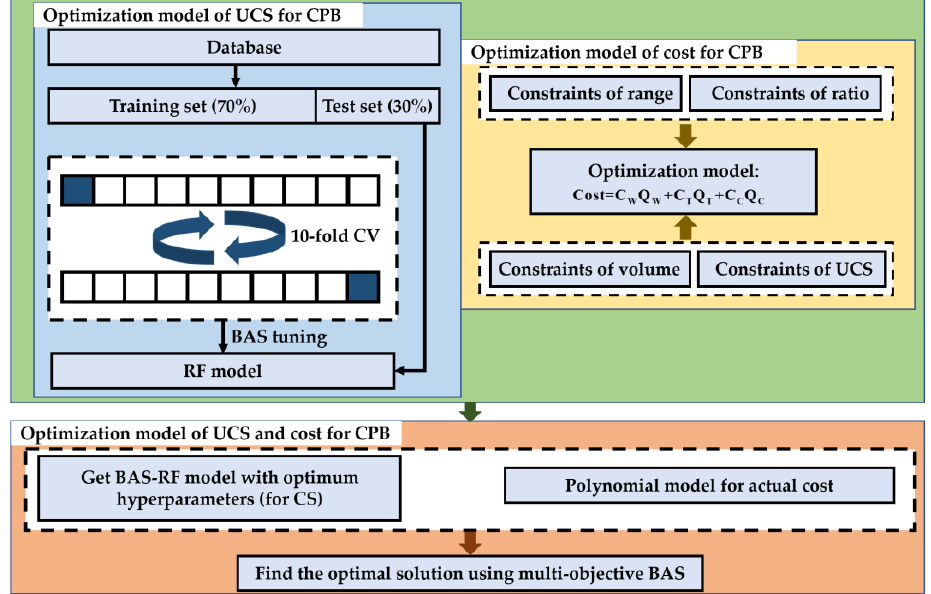
Figure 7. Flow chart for the optimal design of CPB mixtures.